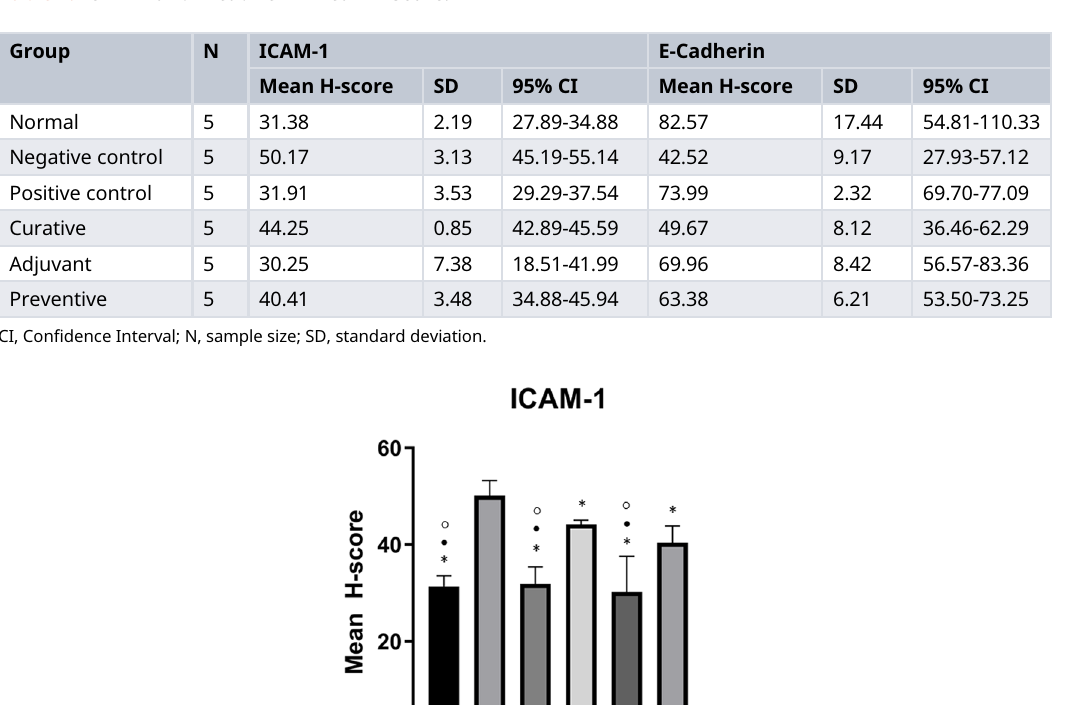
Table 1. ICAM-1 and E-Cadherin Mean H-score.